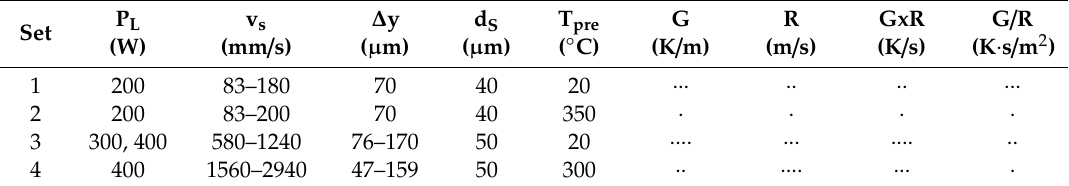
Table 3. Varied parameters in the first evolvement step.